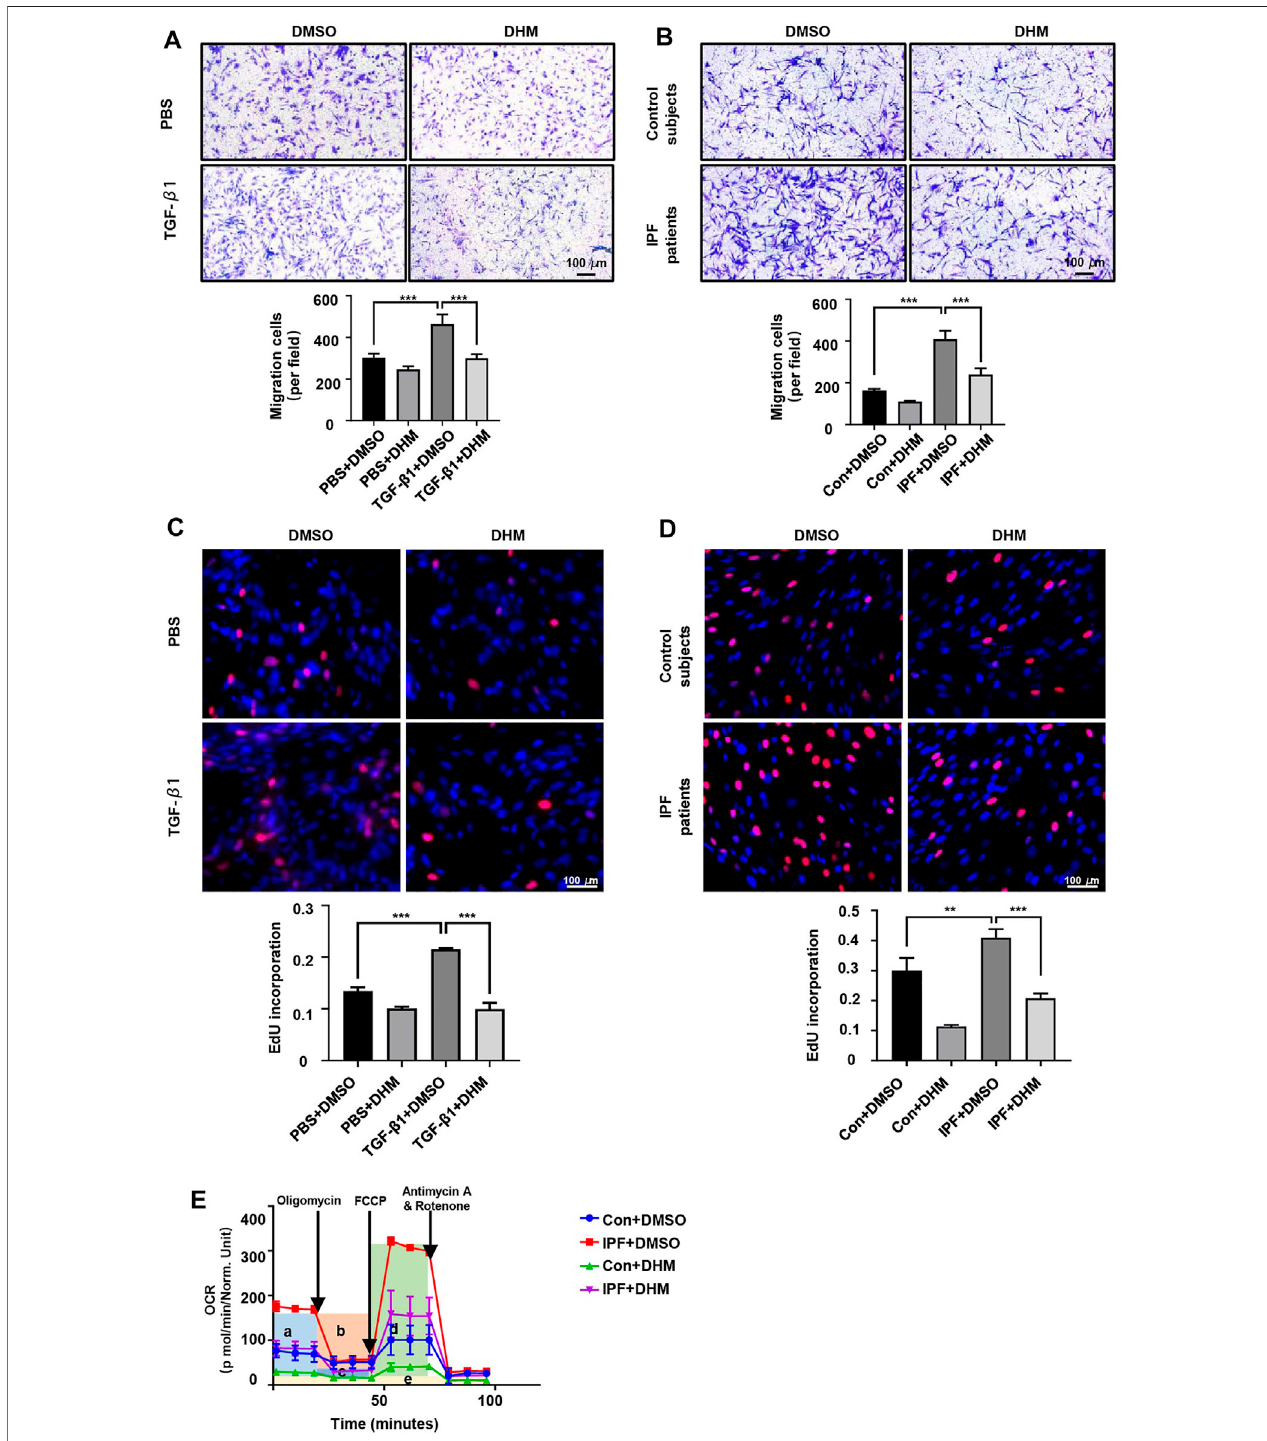
FIGURE 3 | Effects of DHM on the proliferation, migration, and respiratory functions of fi broblasts. (A) Results for the Transwell assay in PMLFs treated with DHM. Images were captured at 100 × magni fi cation ( n = 5). (B) Results for the Transwell assay in PHLFs treated with DHM. Images were captured at 100 × magni fi cation ( n = 5). (C) ResultsforEdUstaininginPMLFstreatedwithDHM.Imageswerecapturedat200×magni fi cation( n =5). (D) ResultsforEdUstaininginPHLFstreatedwithDHM. Imageswerecapturedat200×magni fi cation( n =5). (E) CellMitoStresstestresultsofPLHMswithDHM(a:basalrespiration,b:ATPproduction,c:protonleak,d: maximal respiration, e: nonmitochondrial respiration) ( n = 3). The data are represented as the mean ± SD of three independent experiments. Ordinary one-way ANOVA analysis was applied. *, p < 0.05; **, p < 0.01; ***, p < 0.001.